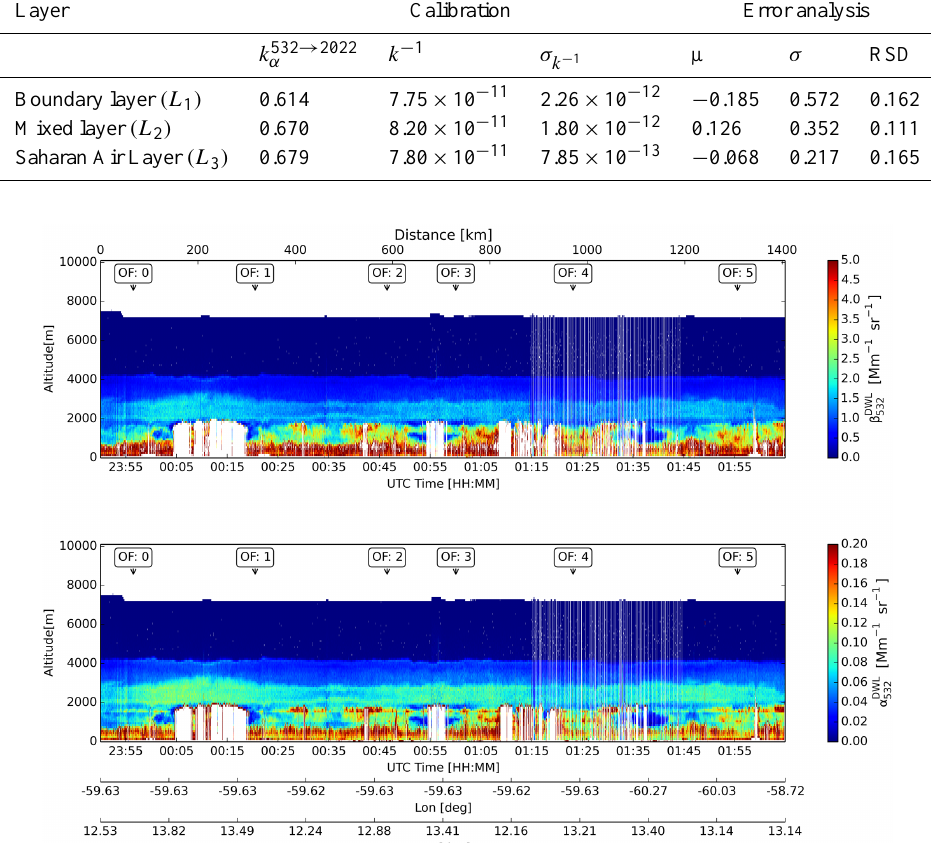
Figure 14. Overview of the retrieved backscatter and extinction coefficient for the flight on 26 June. The label “OF” indicates the time of the overflight over POLIS lidar. The white color indicates regions where no atmospheric signal is available (e.g., below clouds, low laser